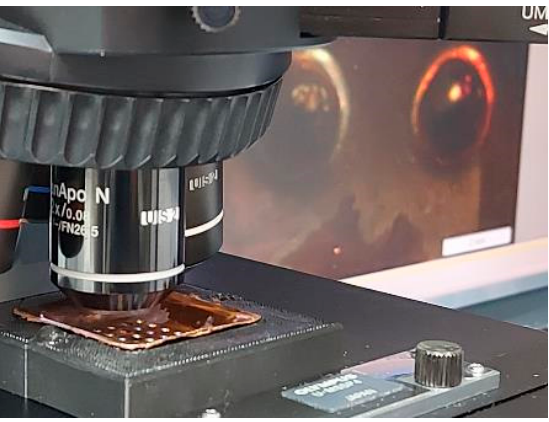
Figure 10. Microscope inspection process.